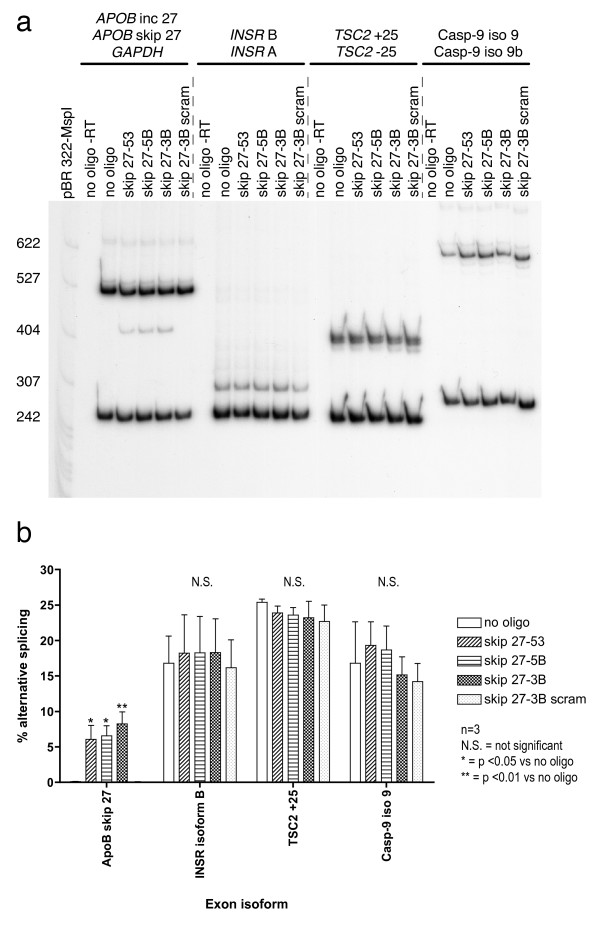
APOB skip 27 ASOs have no effect on the alternative splicing of other exons. (a) The indicated ASOs were transfected at 250 nM into HepG2 cells, and total RNA from these was analyzed by RT-PCR for inclusion/skipping of APOB exon 27; GAPDH, as loading control; inclusion/skipping of insulin receptor (INSR) exon 11; inclusion/skipping of TSC2 exon 25; and inclusion/skipping of Caspase-9 exons 3–6. The identity of each band is listed below each set of 6 lanes from top band to bottom band: APOB inc 27 = exon 27 included; APOB skip 27 = exon 27 skipped, GAPDH = amplified region of GAPDH mRNA 7–261 nt; INSR B = exon 11 included, INSR A = exon 11 skipped; TSC2 +25 = exon 25 included, TSC2 -25 = exon 25 skipped; Caspase-9 isoform 9 = exons 3–6 included, Caspase-9 isoform 9b = exons 3–6 skipped. Transfection of ASOs does not affect the alternative splicing of INSR, TSC2 and Caspase-9. (b) Quantitative data for alternative splicing of each gene from three independent replicates. Error bars represent S.E.M. One-way repeated measures ANOVA of the APOB skip 27 dataset showed p = 0.0007, representing significant statistical differences between groups: Dunnett's multiple comparison test showed statistically significant differences between the no-oligo control and skip 27–53, 5B and 3B, as indicated. One-way ANOVA p-values for the INSR, TSC2 and Caspase-9 datasets were 0.3716, 0.5887, and 0.1674 respectively, indicating no statistically significant differences between groups.